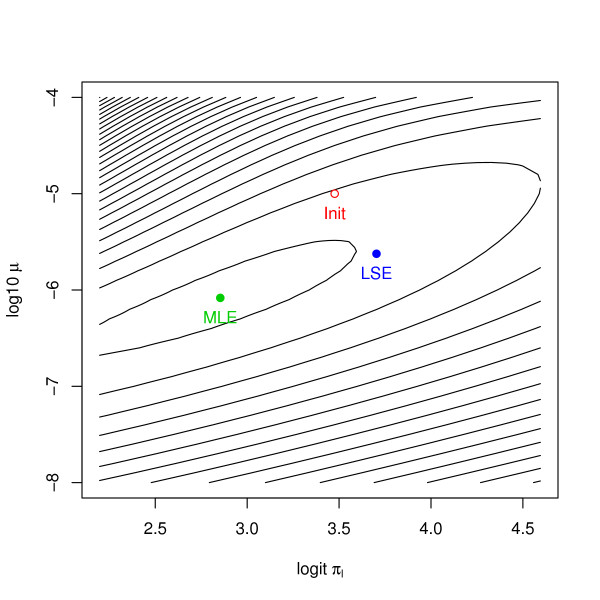
Log-likelihood surface. Contour plot of the log-likelihood surface. The parameter space is reduced by keeping all the parameters except two constant. The two parameters shown are logitπl and log10 μ.